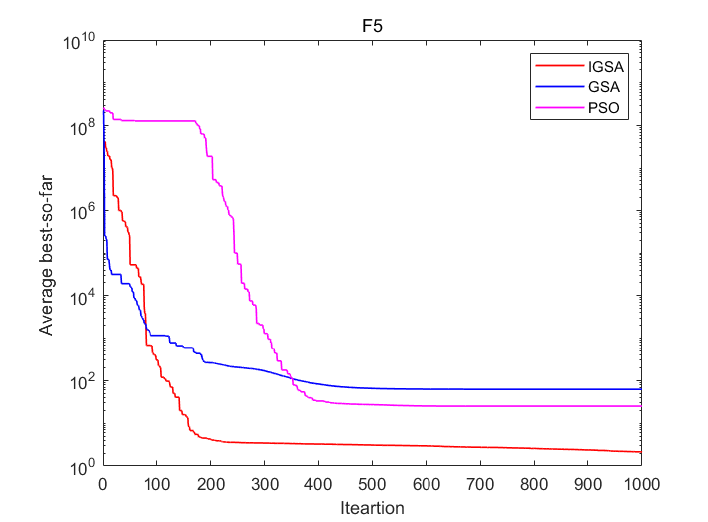
Figure 5. The convergence behavior of F 5 .